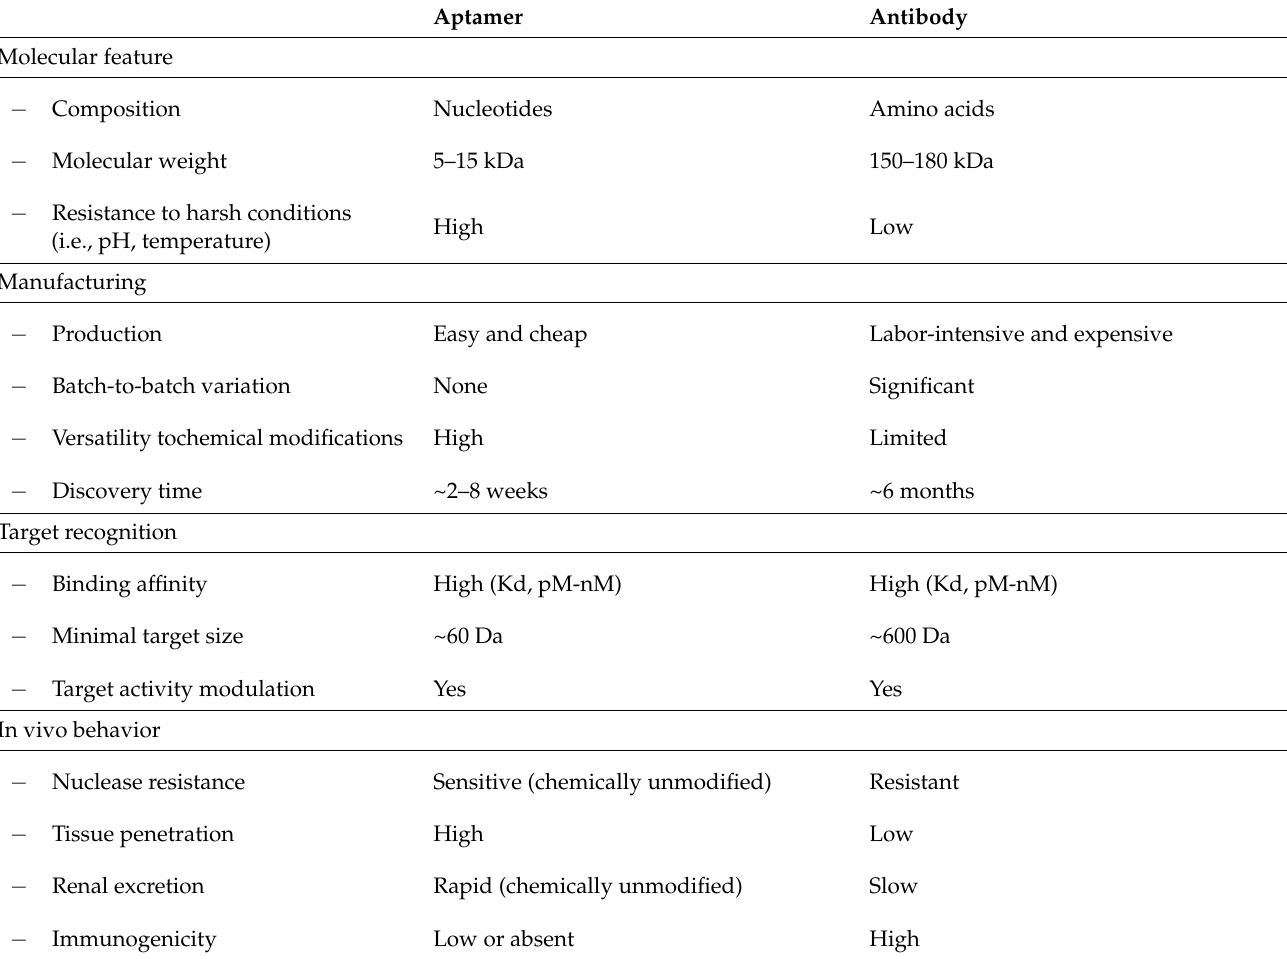
Table 1. Comparative aspects between the aptamers and antibodies for cancer therapy. Aptamer